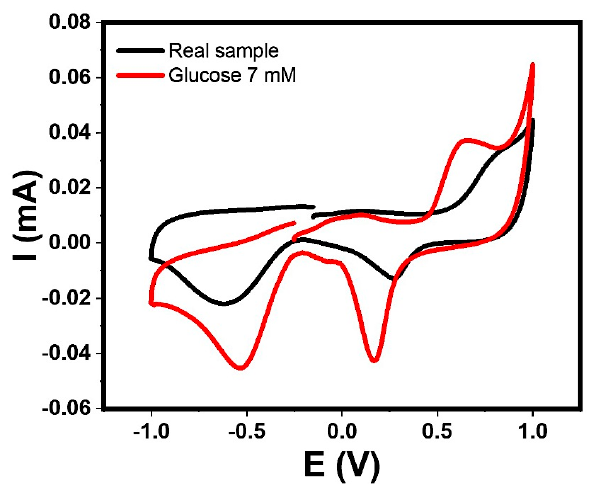
Figure 15. Cyclic voltammogram analysis corresponding to prepared orange juice, and glucose 7 mM. Scan rate: 50 mV/s and window potential: − 1.0 to +1.0 V on CNT-SPE/A/AuNPs in Sorensen buffer pH 7.